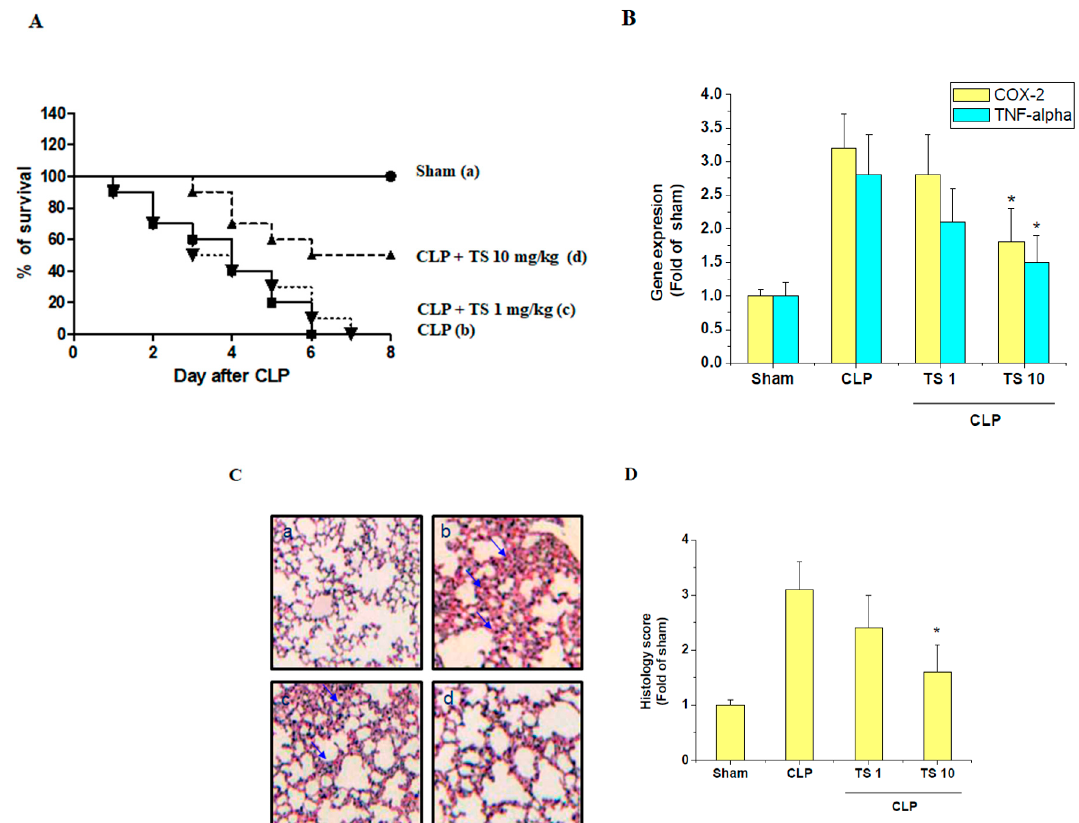
Figure 1. Effect of TS on survival and lung injury in cecal ligation and puncture (CLP)-induced septic mice. ( A ) To examine the effect of TS on the survival of CLP-induced septic mice, survival of mice was then monitored every 24 h for up to 8 days for the following experimental groups (a) sham control; mice were orally administered with either (b) vehicle (corn oil, 0.1 mL per mouse, n = 5), (c) 1 mg/kg TS ( n = 5), or (d) 10 mg/kg TS ( n = 5), 2 h prior to the operation. Significantly different from CLP-induced septic group ( B ) Expression of COX-2 and TNF- α transcripts in the isolated PAM were determined by real-time PCR; * p < 0.05 vs. CLP-induced septic group ( n = 3 in each group) ( C ) The lungs from each experimental group were processed for histologic evaluation 1 day after CLP. Representative histologic changes in lung tissue obtained from mice belonging to each group are displayed and the arrows indicate the damaged area (hematoxylin and eosin staining; magnification 400×). Scale bar represents 200 um. ( D ) The extent of lung injury was estimated using scores in different sections for neutrophil infiltration, hemorrhage, necrosis, congestion, and edema. * p < 0.05 vs. CLP-induced septic group ( n = 3 in each group).